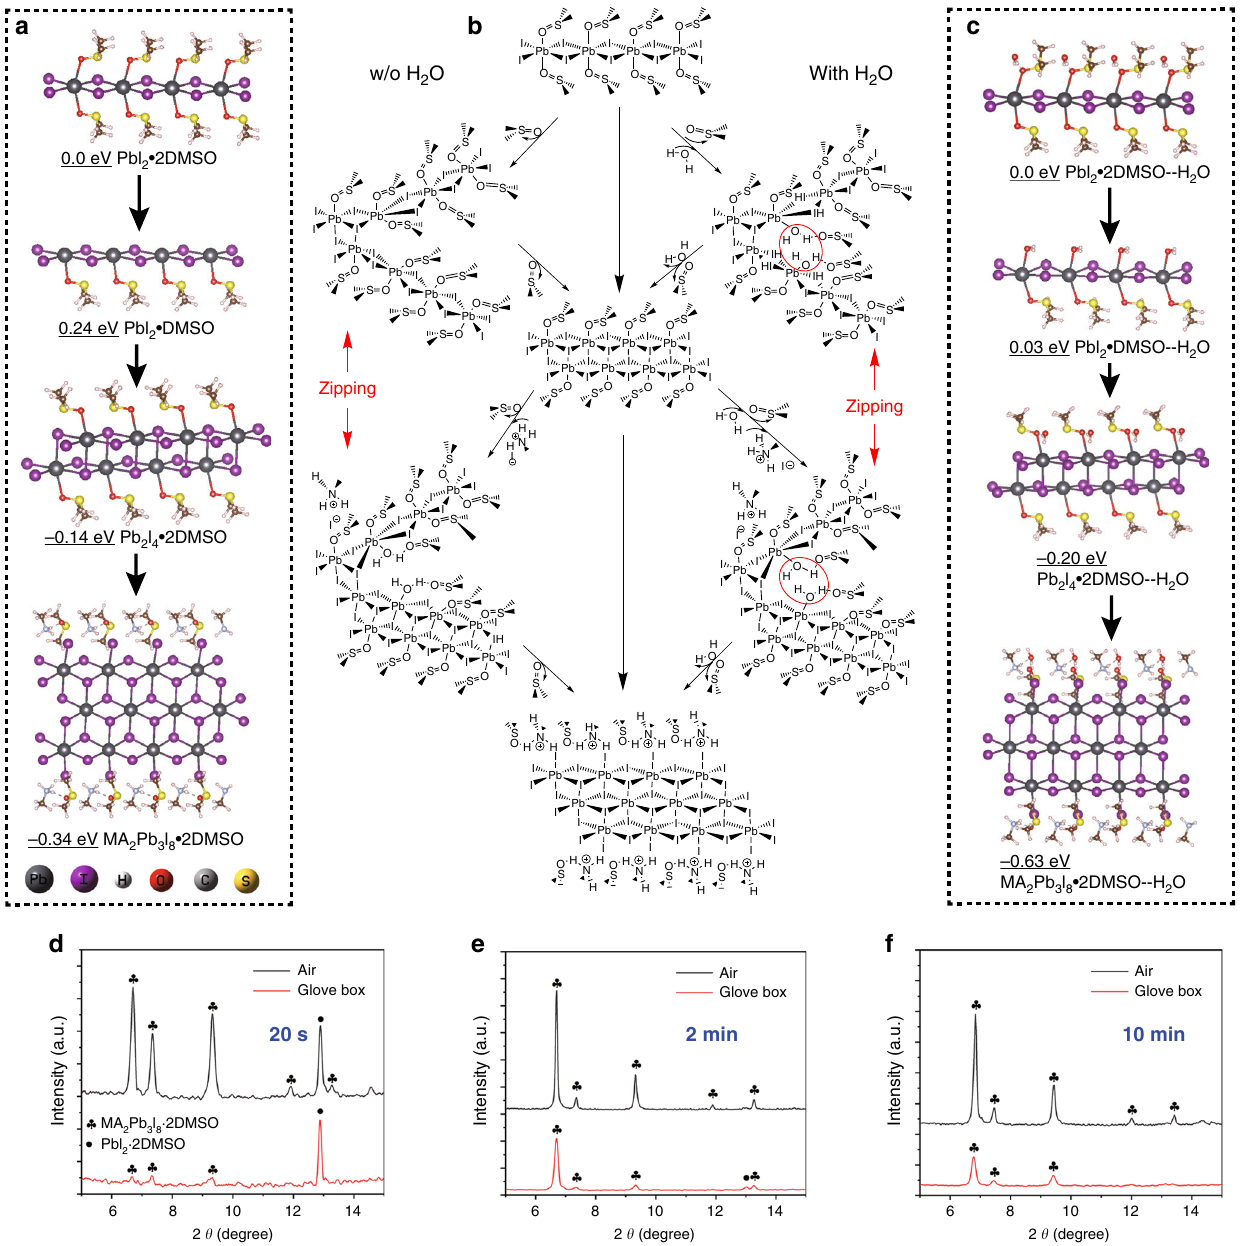
Fig. 1 Water promoted formation of lead complexes — the prenucleation clusters. Calculated structures and electronic energies of lead complexes without H 2 O ( a ) or with H 2 O ( c ). b Schematic illustration of the plausible pathways to the formation of lead complexes, in much the same way as a zipping process. The lead complexes were formed in the absence (left column) and in the presence (right column) of water. The X-ray diffraction patterns (XRD) of Pb-complex fi lms fabricated in ambient air and in glove box with the sample spinning time of d 20 s, e 2 min and f 10 min. The higher Pb-oligomers are easier to form in the presence of H 2 O than in the absence of H 2 O due to the H 2 O-enhanced stabilization and H 2 O-promoted removal of DMSO. Note that the Pb 2 I 4 ·2DMSO oligomer was not observed in the sample spinning process due to the facile conversion to the MA 2 Pb 3 I 8 ·2DMSO intermediate caused by the fast solvent evaporation. Nevertheless, the Pb 2 I 4 ·2DMSO oligomer was observed by simply adding water without spinning the sample (see main text and XRD patterns in Supplementary Fig. than DMSO, it offers a smaller steric hindrance than Pb 2 I 4 ·2DMSO--H 2 O could dissociate the H 2 O and connect yet DMSO does, making it easier and neater to close the ‘ zipper ’ another PbI (Fig. 1b, red circles). To further understand the difference of 3 I 8 ·2DMSO--H 2 O intermediate. Interestingly, the conversion from PbI conversion from PbI 2 ·2DMSO complex to MA 2 Pb 3 I 8 ·2DMSO intermediate between inert environment and ambient air, the electronic energy of each intermediate state was calculated. In the Note that the DMSO and H 2 O molecules should be anhydrous environment, the electronic energy of PbI 2 ·DMSO eliminated once the ‘ zipper ’ is closed. Because H 2 O is smaller complex is 0.24 eV higher than that of the PbI 2 ·2DMSO complex